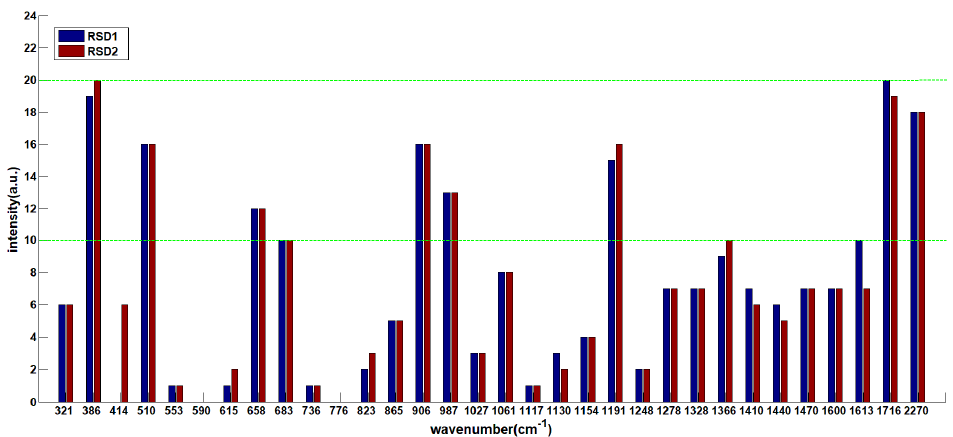
Figure 3. Raman shift deviation between the Raman characteristic peaks of deltamethrin and the Raman characteristic peaks calculated by DFT.